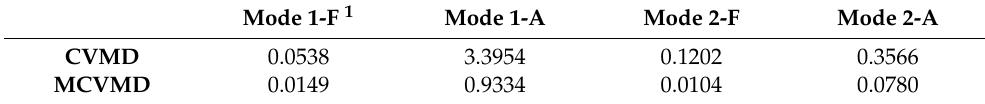
Table 2. The RMSE of the instantaneous frequency and amplitude by CVMD and